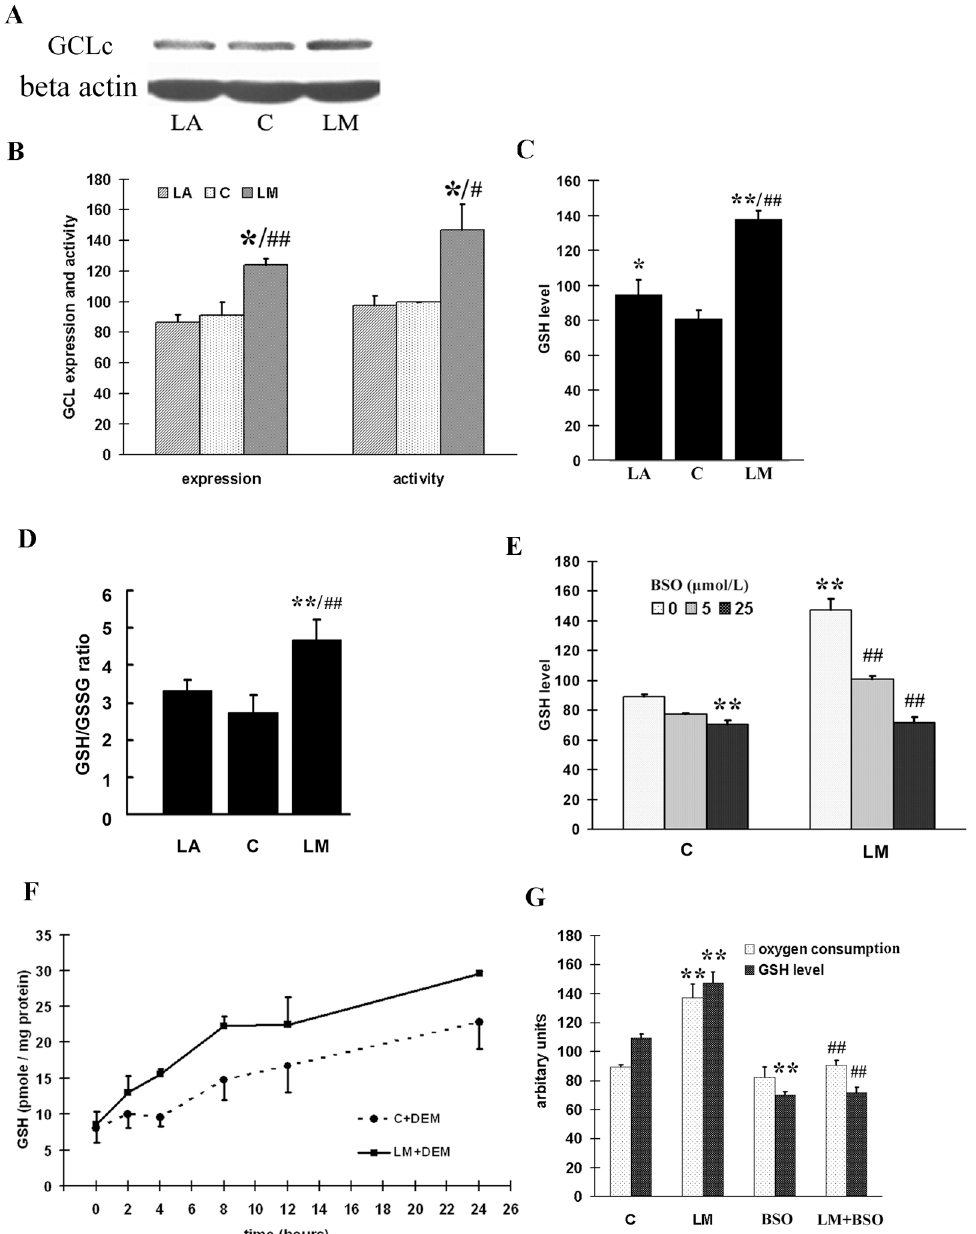
Fig 6. GSH levels was increased in LM treated ARPE-19 cells, and enhanced oxygen consumption was related to de novo GSH synthesis. (A) A representative image of GCLc expression detected by western blot. (B) Quantitative analysis of GCLc expression (4 independent experiments) and GCL activity (3 independent experiments). (C) Quantitative analysis of GSH level. Averages of four independent experiments are displayed in arbitrary units. Values are means ± SEM. (D) Quantitative analysis of GSH/GSSG ratio Total glutathione and oxidative form glutathione (GSSG) was measured as described in method, GSH/GSSG ratio was caculated. Values are means ± SEM from three independent experiments. (E) LM increases GSH levels by GCL activation. ARPE-19 cells were treated with or without 40 μ mol/L LM, and 5 or 25 μ mol/L BSO was added to the media at the same time; after 48 h, GSH levels were measured spectrometrically as described in Materials and Methods. The results in arbitary units are averages of three independent experiments. Values are means ± SEM. (F) LM treatment improved recovery of cellular GSH levels with time. ARPE-19 cells were treated with or without 40 μ mol/L LM for 48 h, and then exposed to media containing 2 mmol/L diethyl maleate (DEM) for 90 min to deplete cellular GSH; the recovery of GSH was examined over time. LM+DEM recovery was significantly higher than C+DEM. The results are shown as means ± SEM from four independent experiments. Statistical significance was established by two way ANOVA followed by the LSD test. (G) Effect of LM on BSO-induced decrease in oxygen consumption and GSH levels. ARPE-19 cells were treated with or without LM (40 μ mol/L) or BSO (25 μ mol/L) for 48 h, then the GSH level and oxygen consumption were examined as described in Materials and Methods. Values are means ± SEM of three independent experiments. For A, B, C, D, E and G, statistical significance was